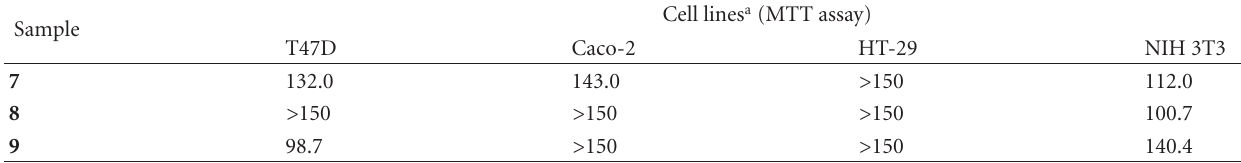
Table 3: The e ff ects of dihydrochalcone and flavanones isolated from S. spicigera on the viability of various cell lines using MTT